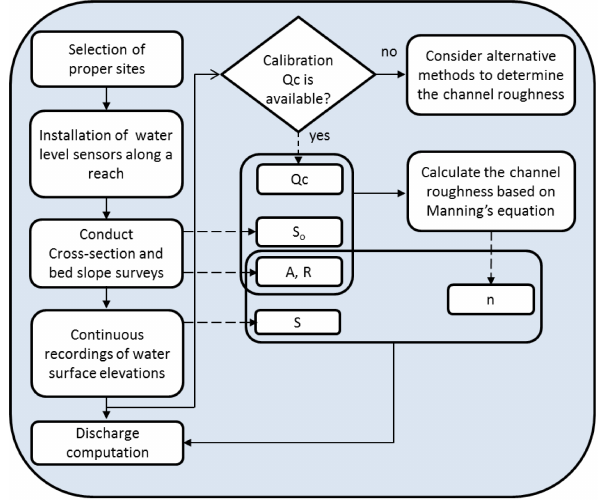
Figure 5. A schematic diagram of the CSA method implementation